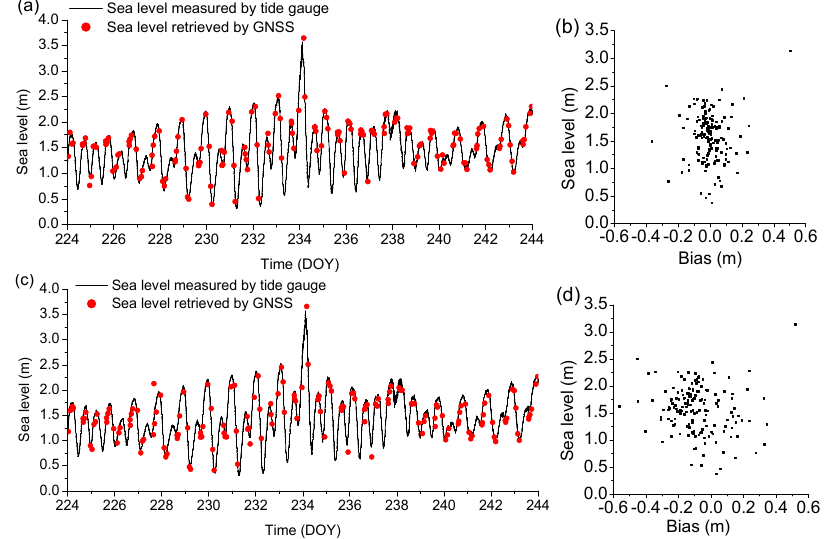
Figure 5. GPS L2C retrievals with and without correction of height variation error: ( a ) retrieved sea levels with correction of height variation error and measured sea-level series; ( b ) bias of retrievals in ( a ) versus sea-level measurement; ( c ) retrieved sea levels without correction of height variation error and measured sea-level series; ( d ) bias of retrievals in ( c ) versus sea-level measurement. For retrievals with correction of height variation error in Figure 5a, the RMSE was 9.3